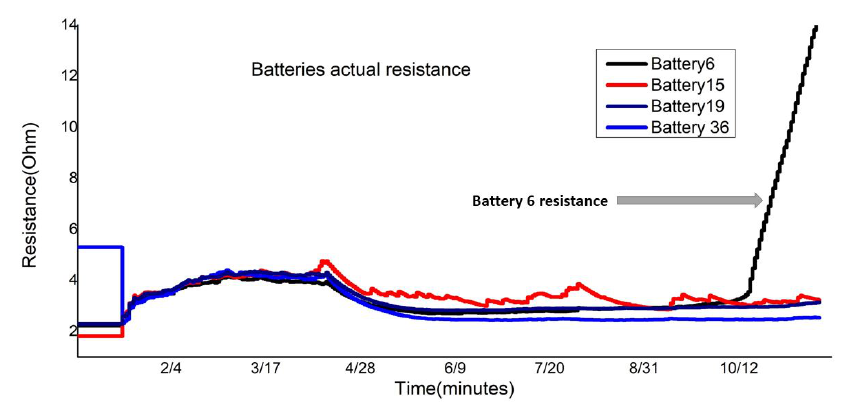
Figure 15. One-year actual voltage value, voltage drop in Battery 6, as well as stable voltages for Battery 15, 19, and 36, validate the proposed method.